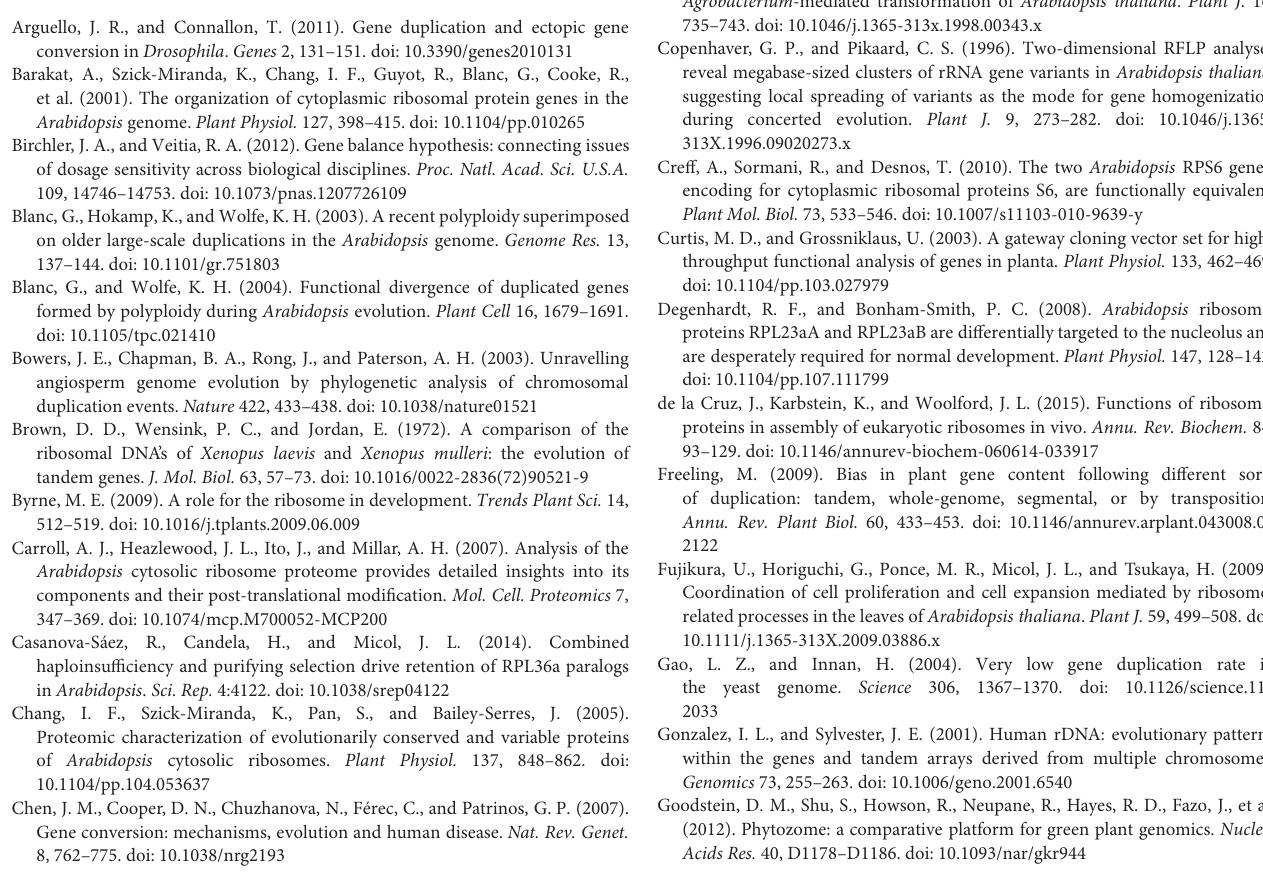
Exons (orange) and introns (black, lower case) are shown with initiation codons highlighted in green and stop codons highlighted in yellow. FIGURE S3 | RPL4 genes in Brassicaceae occur in regions of synteny. CoGe outputs showing regions of synteny around A. thaliana RPL4D and RPL4A , A. thaliana RPL4D and A. lyrata AlRPL4D and A. thaliana RPL4D, and C. rubella CrRPL4D (A) , and regions of synteny around A. thaliana RPL4C and A. lyrata AlRPL4C , and A. thaliana RPL4C and C. rubella CrRPL4C (B) . Chromosomes are indicated as dotted black lines with genes (green) indicated on both Watson and Crick strands. Regions of identified sequence similarity (pink) are shown above the chromosomes. Interconnecting lines between chromosomes (pink) mark RPL4 genes. FIGURE S4 | RPL4 pseudogenes in Brassicaceae. Alignment of nucleotide sequences of P group genes. Start and stop codons are highlighted in red. The C. grandiflora RPL4C gene sequence is likely incomplete. FIGURE S5 | RPL5 genes in Brassicaceae occur in regions of synteny. CoGe outputs showing regions of synteny around A. thaliana RPL5A (A) and RPL5B (B) genes with RPL5 genes in A. lyrata and C. rubella. Chromosomes are indicated as dotted black lines with genes (green) indicated on both Watson and Crick strands. Regions of identified sequence similarity (pink) are shown above the chromosomes. Interconnecting lines between chromosomes (pink) mark RPL5 genes. FIGURE S6 | Phylogenetic trees of RPL27a, RPL36a, and RPS6 genes in Brassicaceae. Phylogenetic trees of RPL27a (A) , RPL36a (B), and RPS6 (C) includes A. thaliana , A. lyrata , C. rubella , C. grandiflora , E. salsuginum , B. rapa, and D. melanogaster